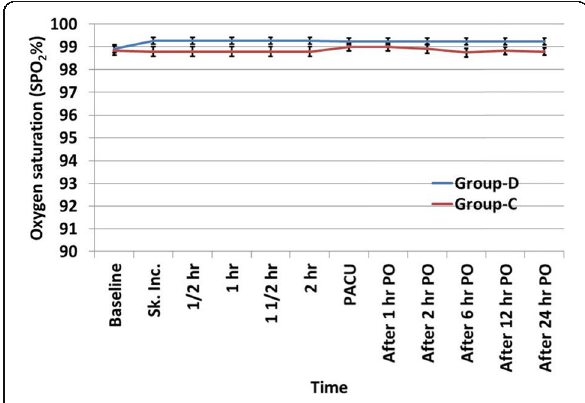
Fig. 3 Comparison between the C group and D group according to SPO